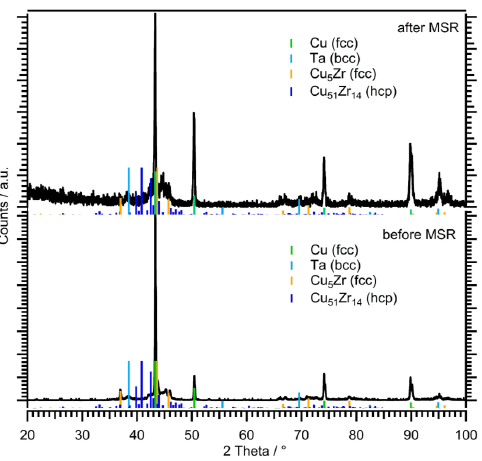
Figure 10. XRD analysis of the Cu ‐ Zr sample with a nominal Cu:Zr = 9:2 stoichiometry: before MSR ( lower panel ); and after MSR ( upper panel ).